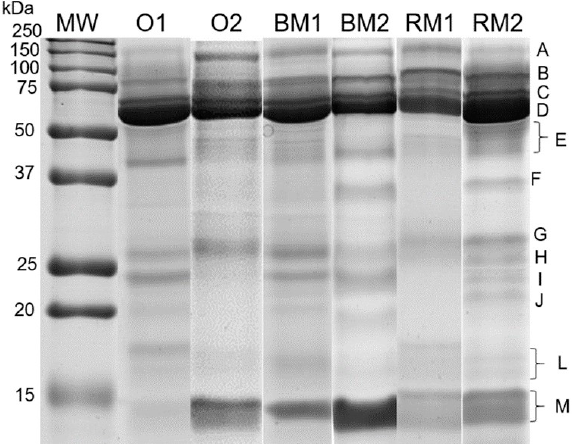
Figure 2. Sodium dodecyl sulphate-polyacrylamide gel electrophoresis (SDS-PAGE) salivary